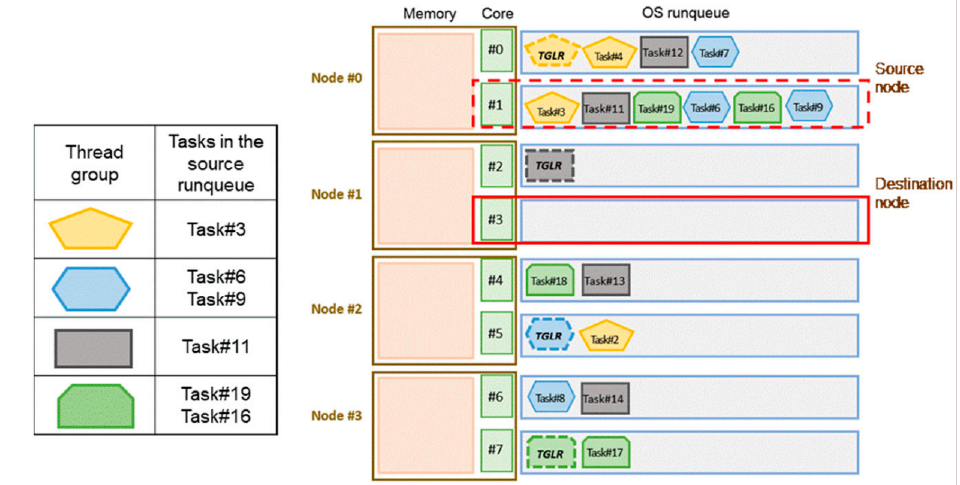
Figure 7. Several multithreaded processes running on a 4-node NUMA system.